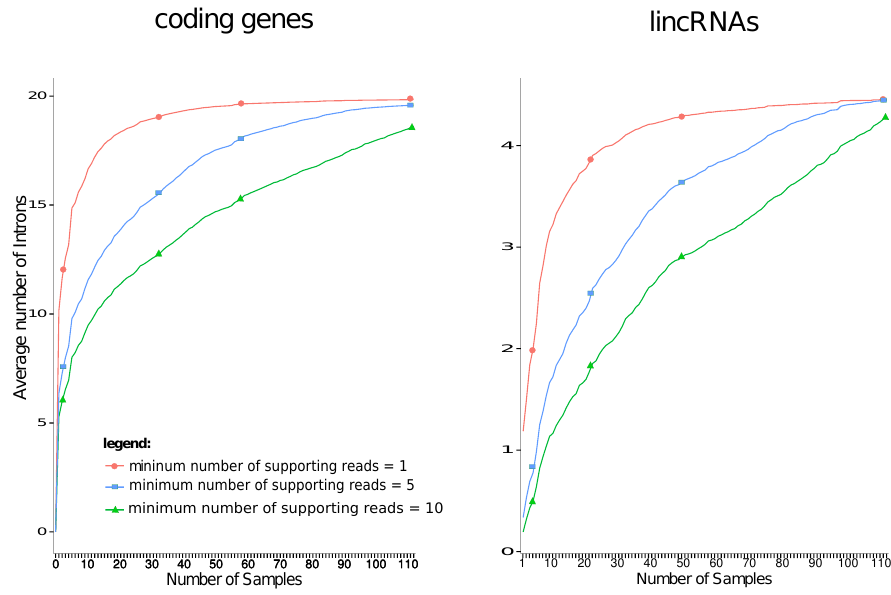
Figure 1. Saturation curves for the number introns as a function of the number of independent transcriptome samples. The lncRNAs data refer to the 1441 annotated genes in the lymphome dataset with at least one